Question: Is the quantity shown trending increasing or decreasing?
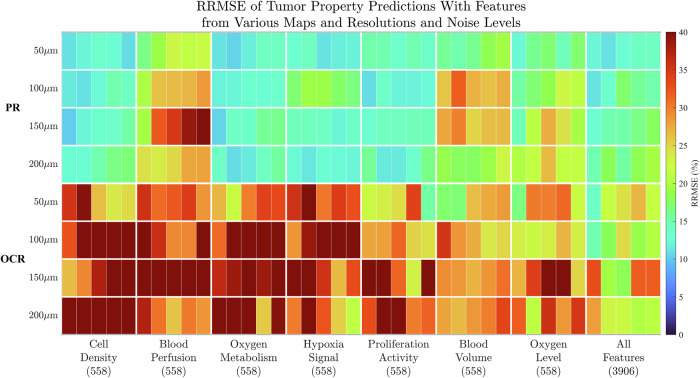
Answer: increasing